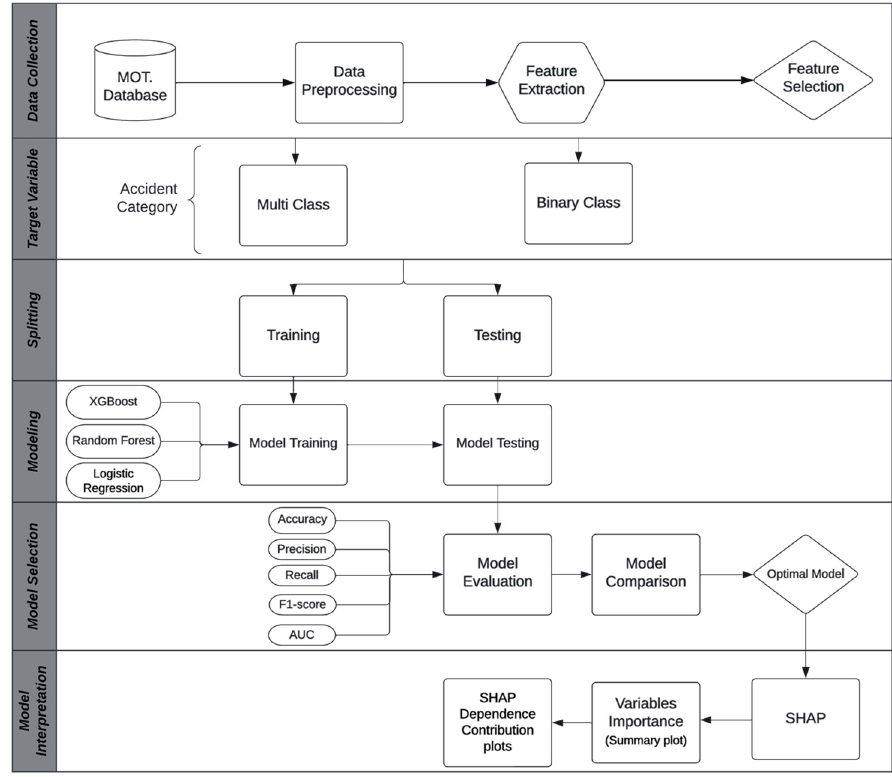
Figure 1. Severity prediction